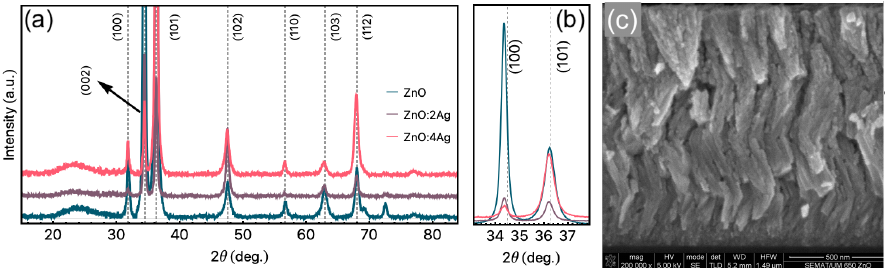
Figure 2. ( a ) X-ray diffraction results obtained for our samples. The peaks were indexed using the ICSD-01-072-0067 card (space group p63mc). In particular, the vertical axis is linear scale. ( b ) view of the X-ray diffraction showing the peaks related to the preferential growth direction. ( c ) Representative cross-section SEM image. Here we show the cross-section image obtained for the pure ZnO film. Using the software ImageJ we infer the thickness of the film as around 1.2 µ